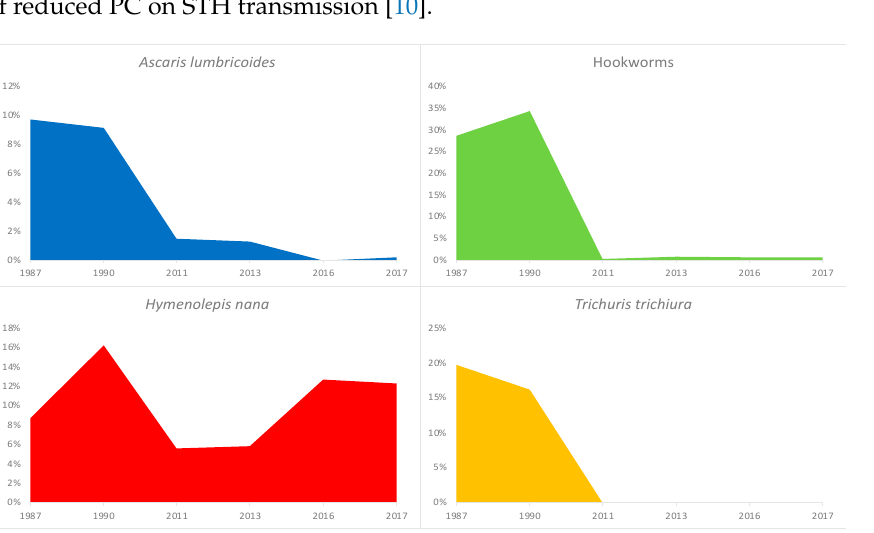
Figure 2. Soil-transmitted helminths trend during 1987–2017 in the Bolivian Chaco. A Hymenolepis nana trend was also shown as an example of the feco–oral-transmitted parasite. The study population constituted a general population in 1987 ( n = 381) [5] and 2013 ( n = 223) [9], pre-school- and school-aged children (SAC) in 1990 ( n = 179) [10] and 2011 ( n = 268) [7], and only SAC in 2016 ( n = 426) and 2017 ( n = 520) [10]. In 1987 and 2011, the surveyed areas included both rural and urban areas, while other surveys were limited to rural areas.